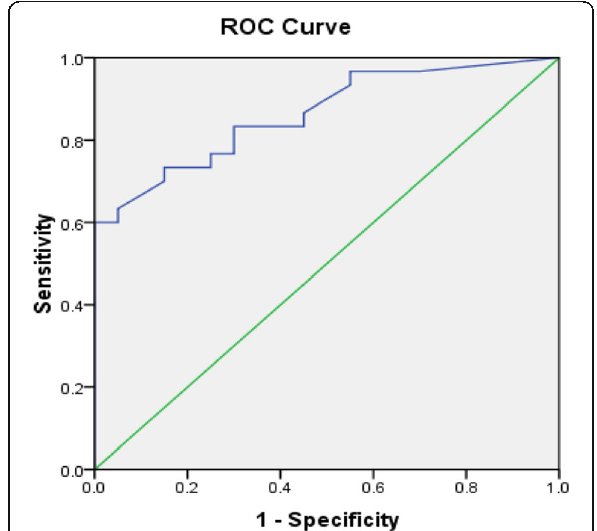
Fig. 8 ROC curve for determination of CVS sensitivity and specificity in MS